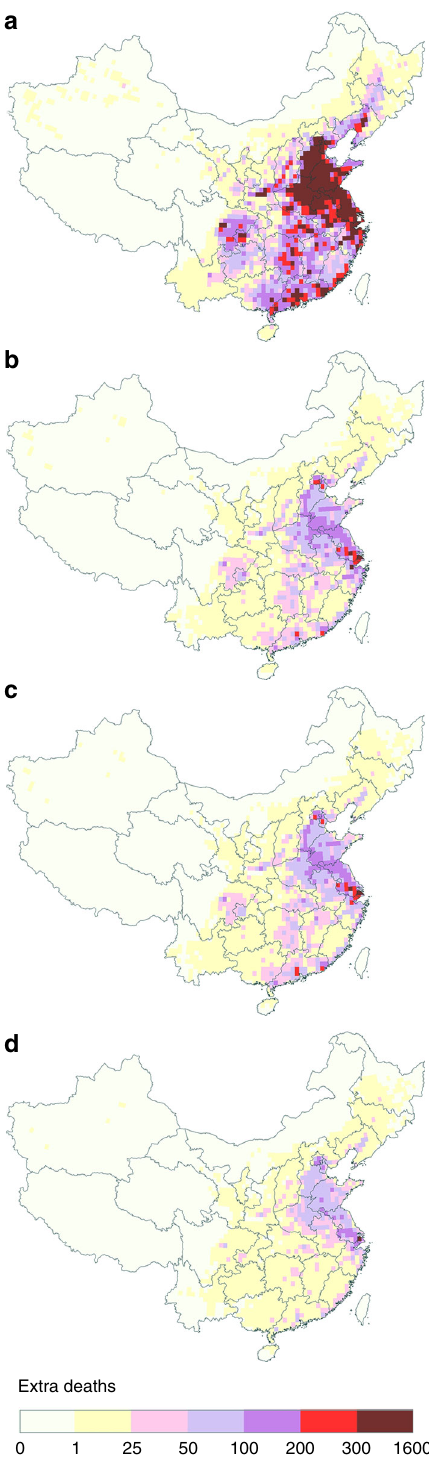
Fig. 1 Premature deaths attributable to ambient PM 2.5 associated with air pollutant emissions embodied in international exports from